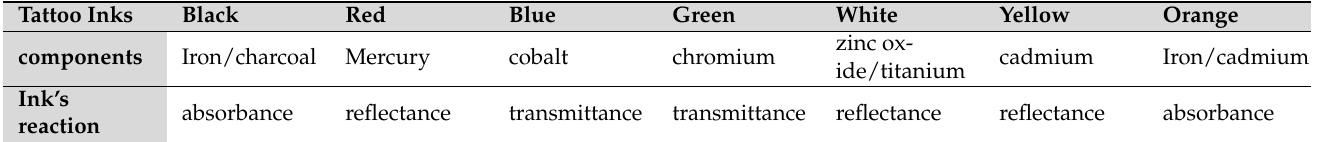
Table 2. Reactions of different tattoo inks to infrared